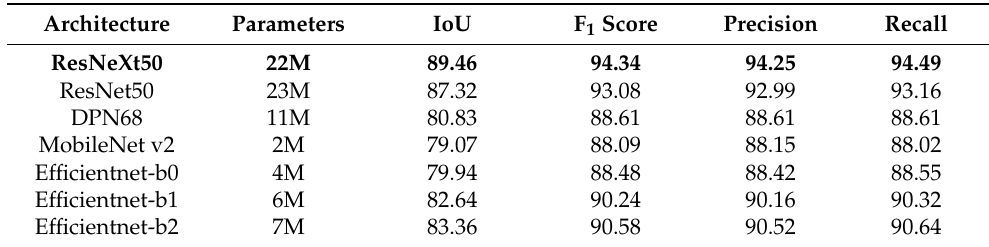
Table 3. Comparison of the Encoders using the DeepLabv3+ segmentation architecture (bold font indicates the bests performing